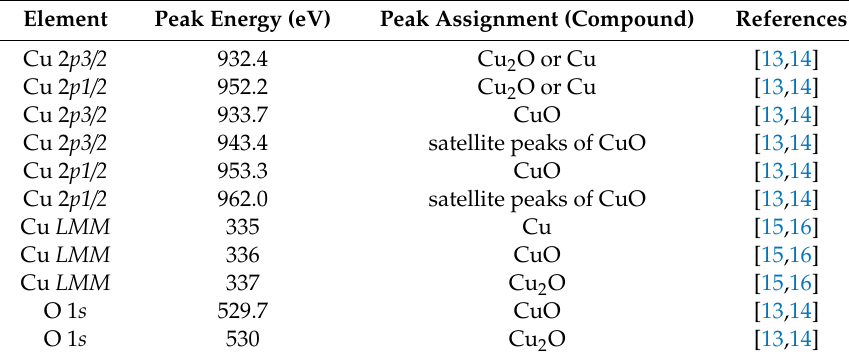
Table 3. Peaks of bonding energies (eV) and auger transition kinetic energy (eV).